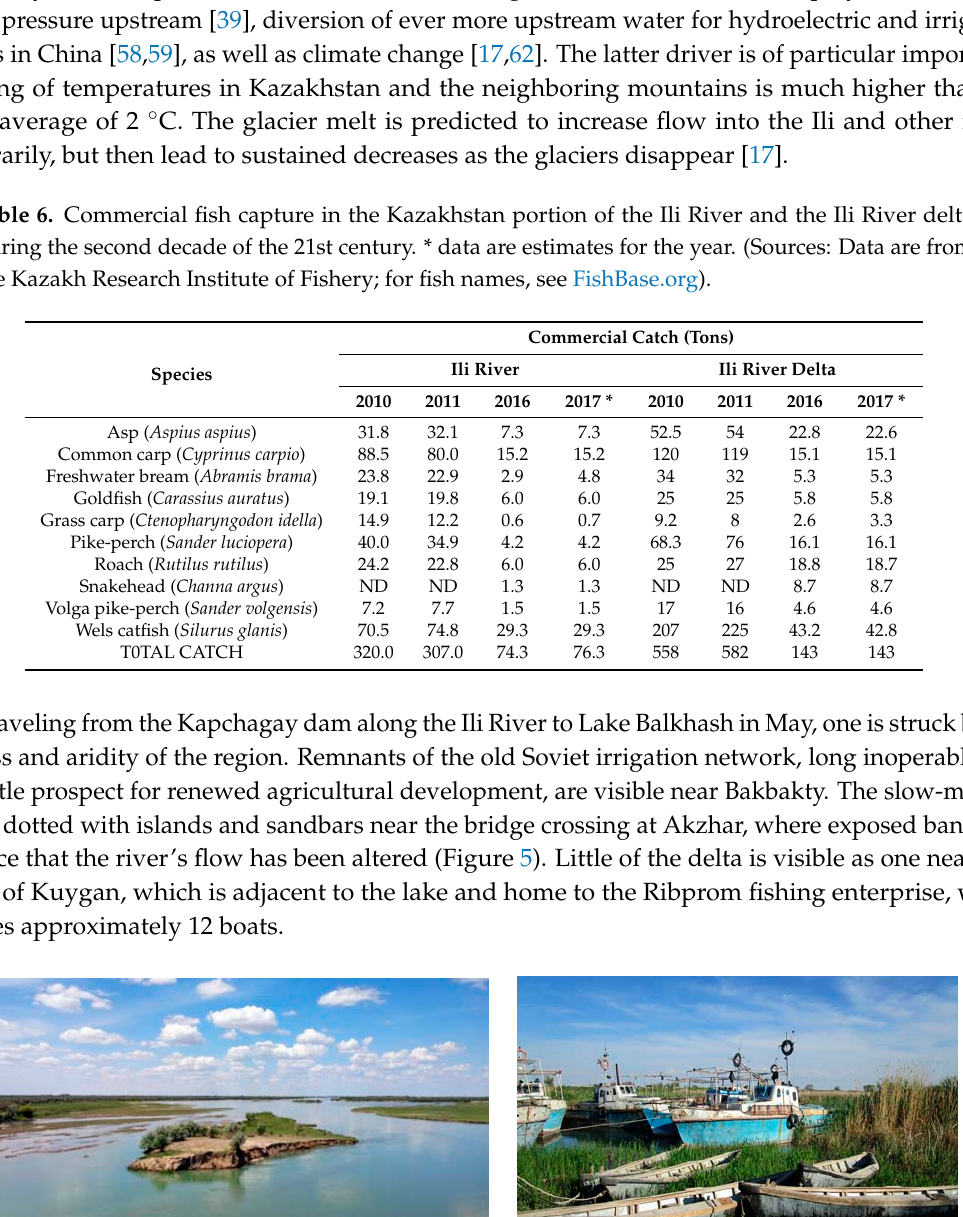
Table 5. Fishing employment and fleet on Lake Balkhash 2010–2015. * data based on 8 months of observation. (Source: Kazakh Research Institute of Fishery).